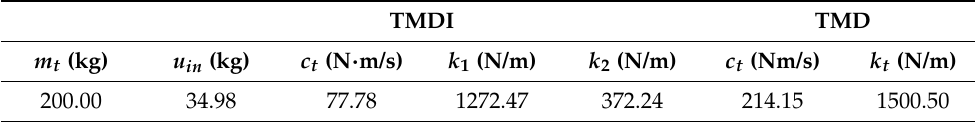
Table 2. Parameters of TMDI and TMD for the specific SDOF